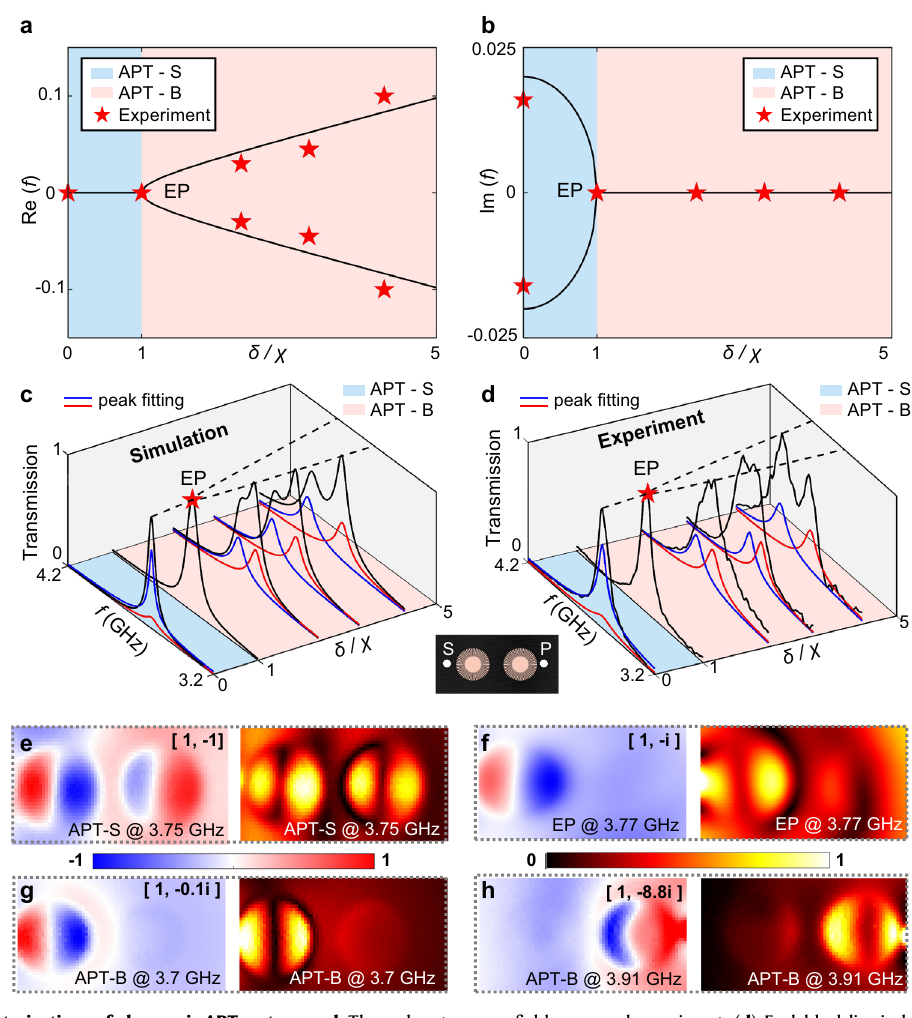
near- fi eld-measuredexperiments( d ).Eachblacklineisdecomposedintoablueand a red line, according to mode decompositions. The inset shows the setup for both simulationsandmeasurements.The ‘ S ’ and ‘ P ’ denotethelocationsofthenear- fi eld source and proberespectively. e – h Themeasured near- fi elddistributions of APT-S (| δ / χ |=0), EP(| δ / χ |=1), and APT-B phases (| δ / χ |=4.46), respectively. The distribu- tions of E z and | E z |are shown with rainbow and hot colors,